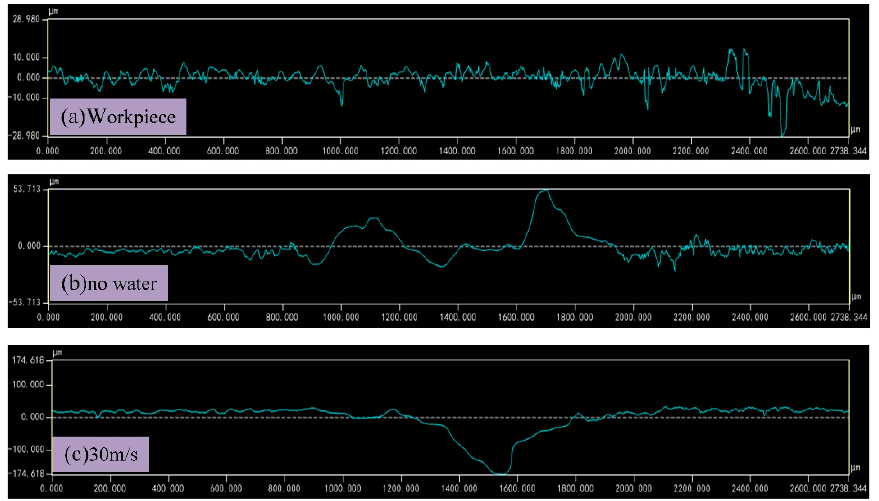
Figure 8. Roughness before and after laser processing.